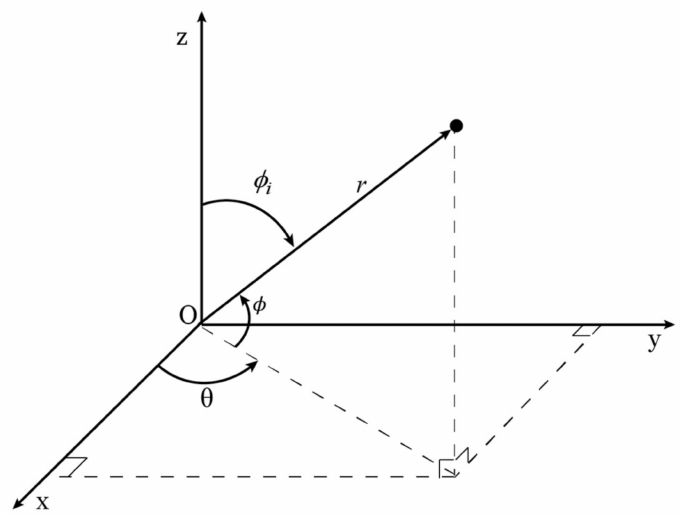
Figure 3. Referential used on the satellite motion equations—spherical coordinate system.